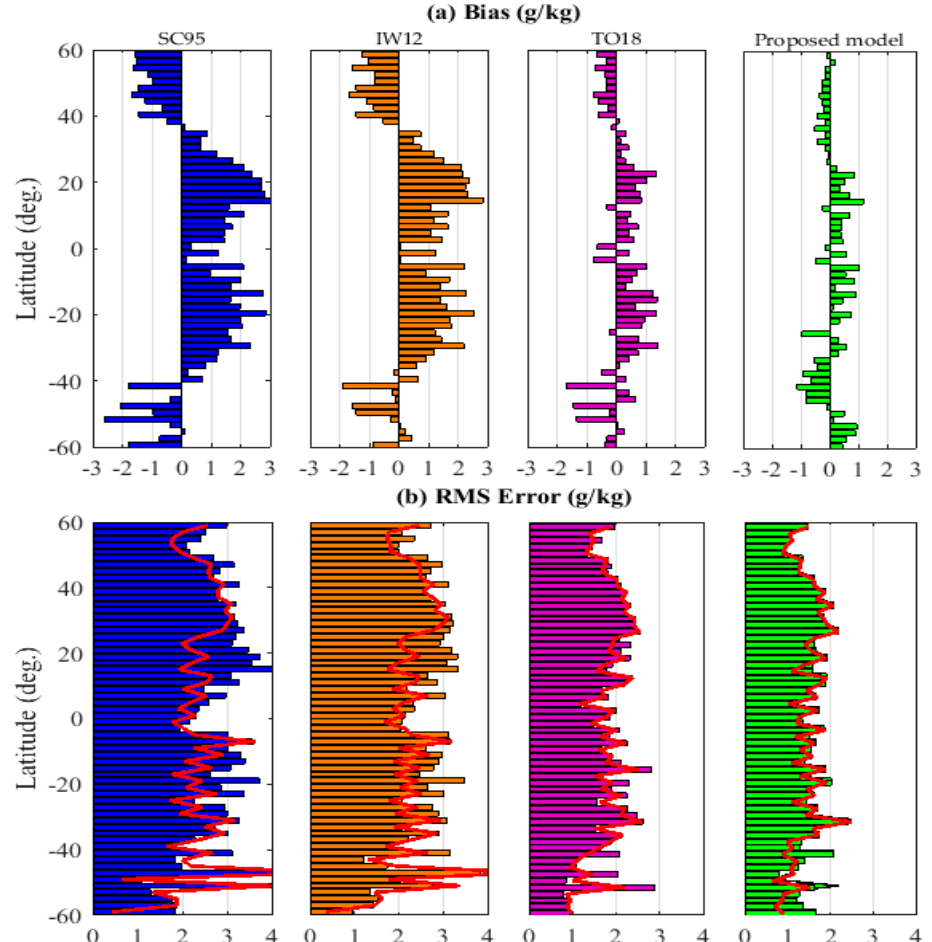
Figure 9. Zonal distributions of the comparative statistics between in situ observed and satellite-derived Q a values for four algorithms, including ( a ) averaged bias, ( b ) root mean square difference (RMSD), and standard deviation difference (SDD, plotted as red lines). Statistics were averaged for each 2° bias.